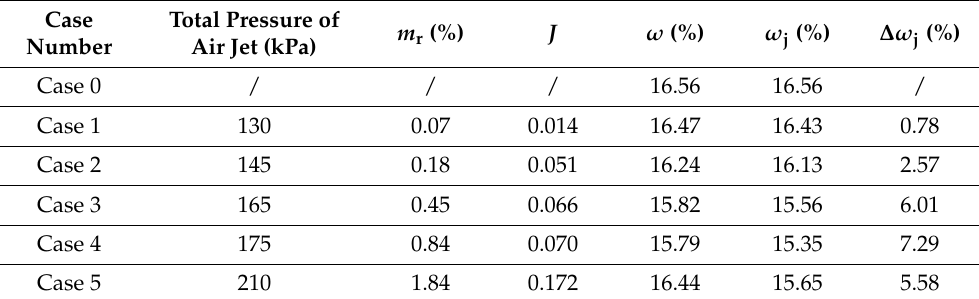
Figure 8. Profiles of variations of total pressure loss coefficient and improved effect with different strengths of jet. Table 2. Related parameters of various strength of air jet.